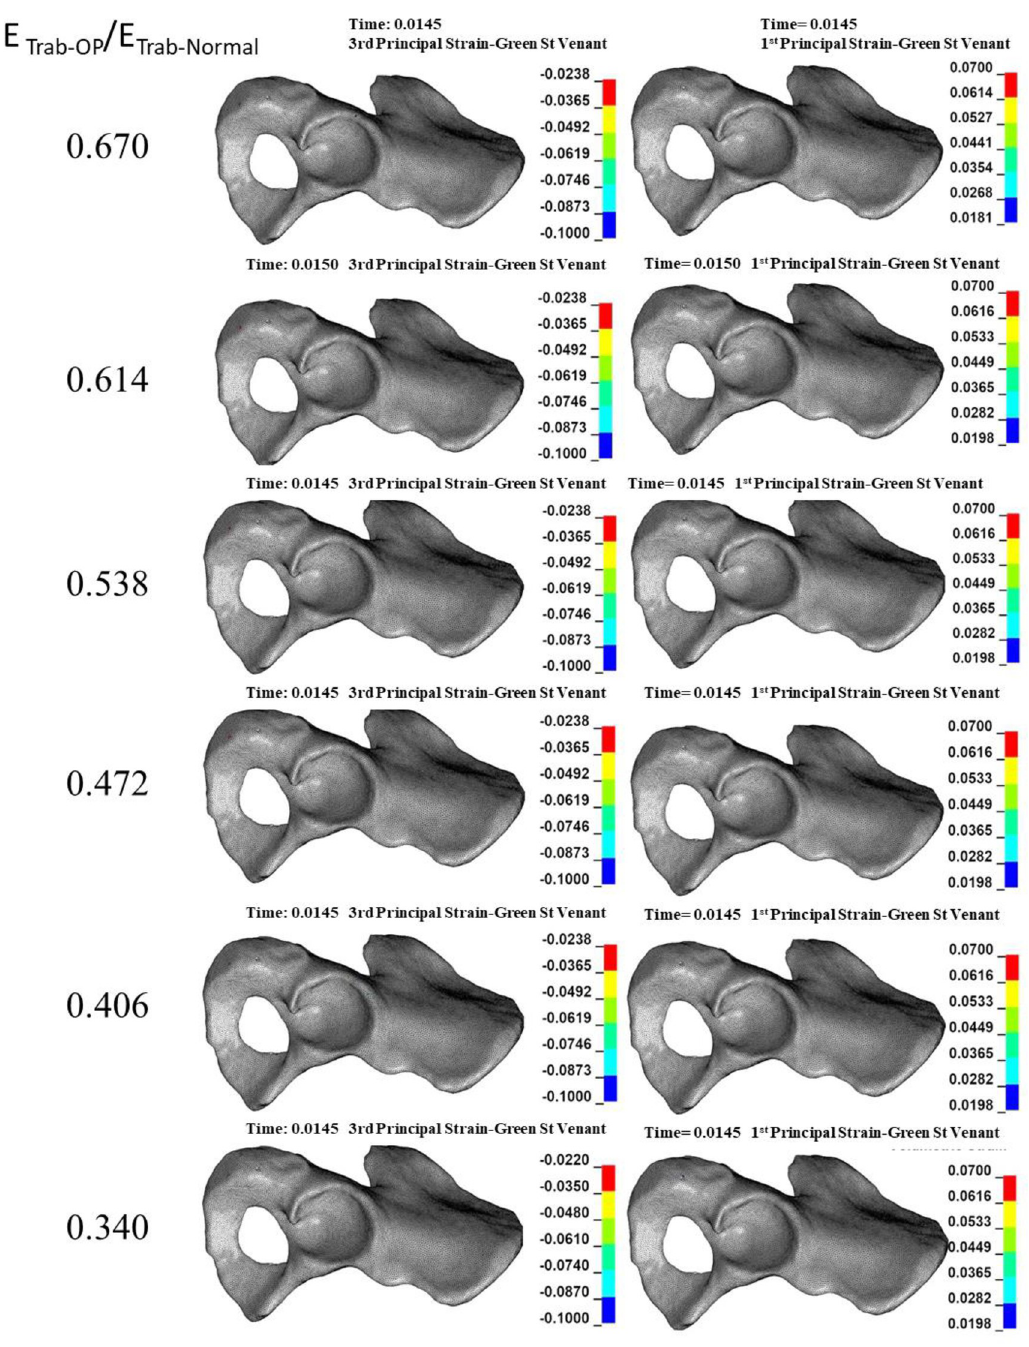
Fig 3. Effect of reduction in trabecular elastic modulus (E Trab ) on the compressive (left column) and tensile (right column) cortical bone failure. Neither tensile nor compressive cortical bone failure was observed. E reduction (Fig 8B). In contrast, the maximum transmitted force within the pubic Cort-Normal symphysis increased by 13.2% when E /E reduced from 0.835 to 0.670 (Fig Cort-OP Cort-Normal 8C).